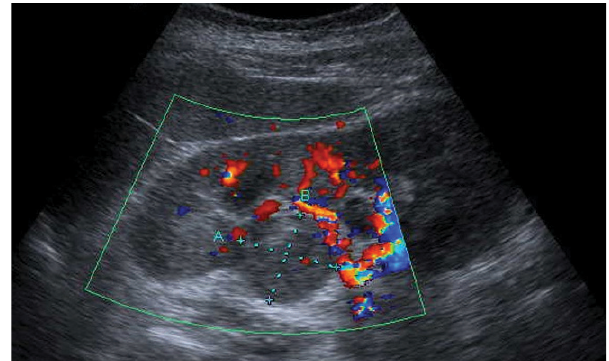
Figure 3 - The focal area of pyelonephritis in the left kidney on color